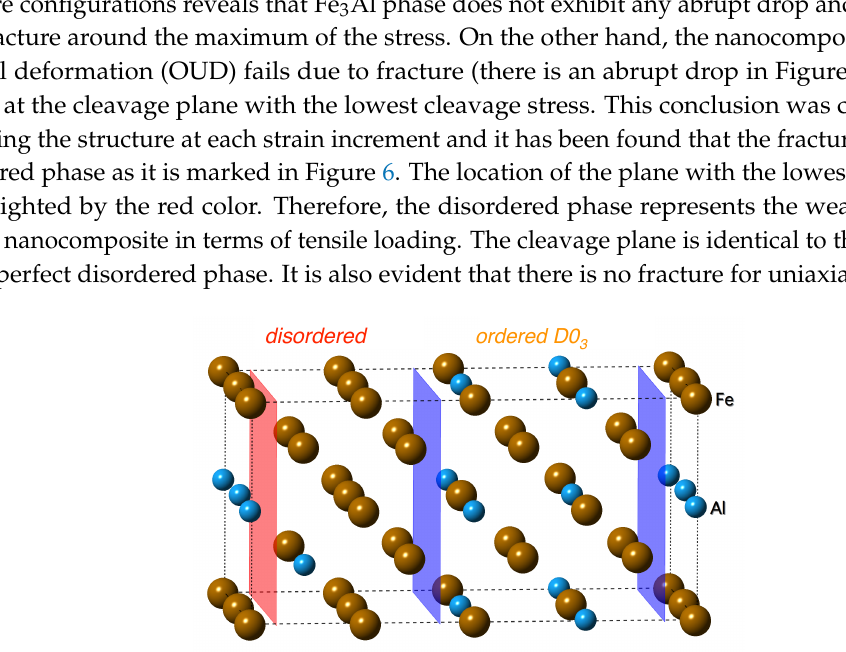
Figure 6. The location of the cleavage plane highlighted by the red plane. The blue planes mark the interfaces between D0 3 and disordered